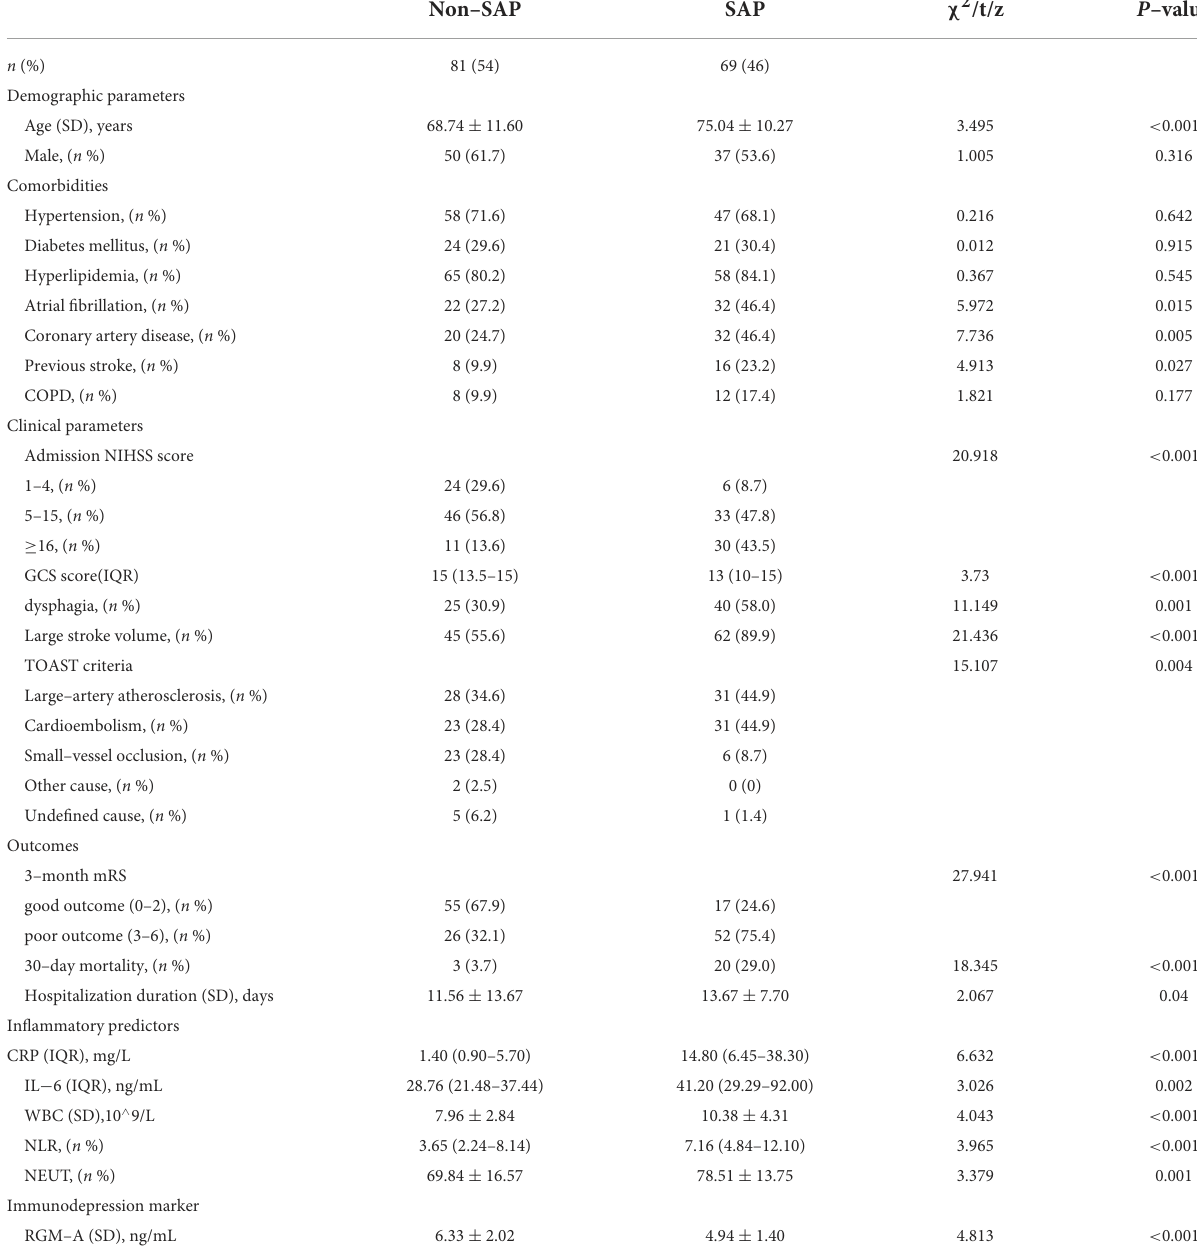
TABLE 1 Characteristics and clinical data of patients with AIS with and without SAP. Non–SAP SAP χ 2 /t/z P